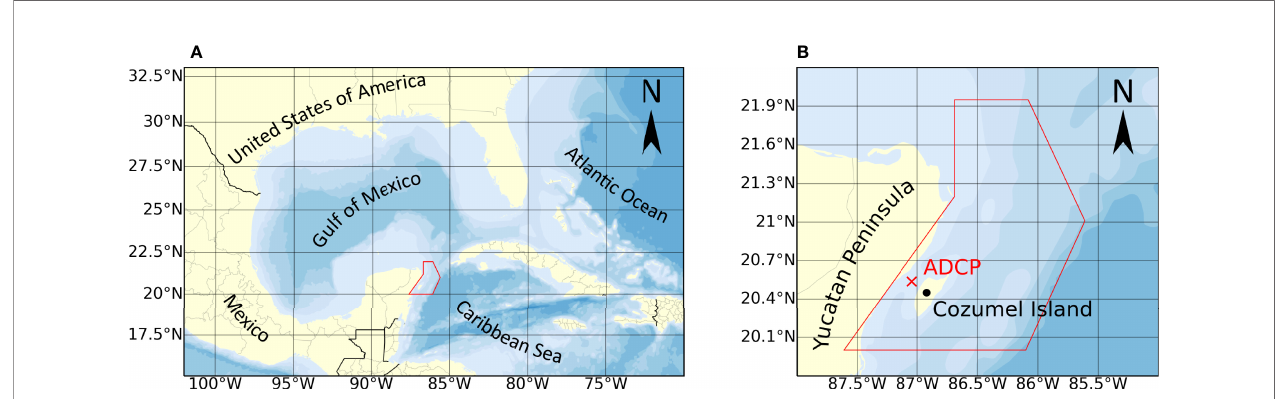
FIGURE 1 | (A) Study area within the Mexican Caribbean and (B) position of the acoustic Doppler current pro fi ler